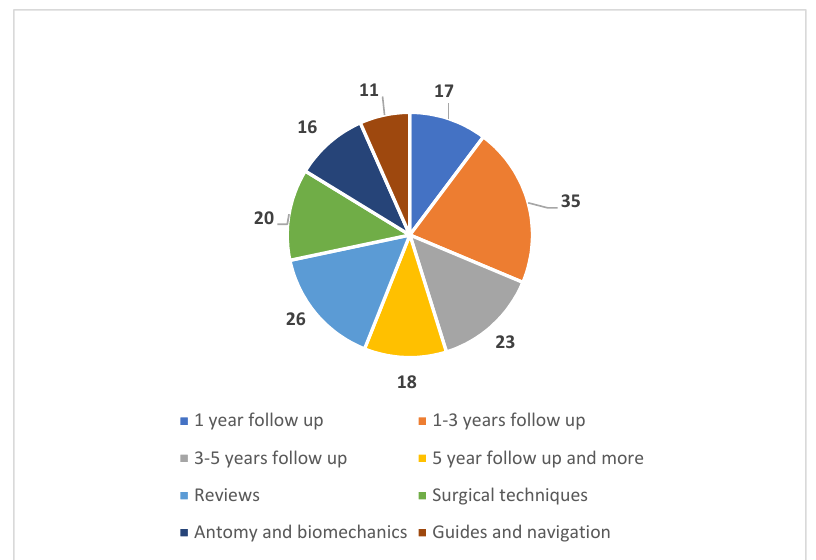
Figure 3. Classification of the 196 selected articles compiled according to their theme, separating them into three large sections: clinical cases, reviews and others.